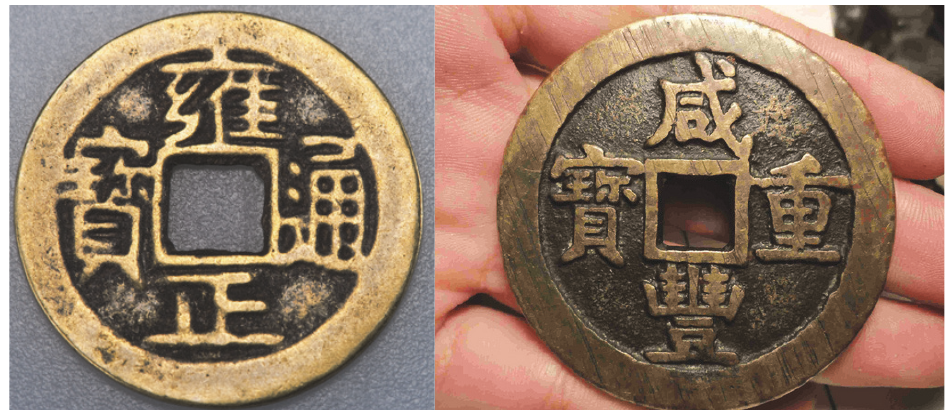
Figure 2: Photographs of ancient Chinese copper coins.